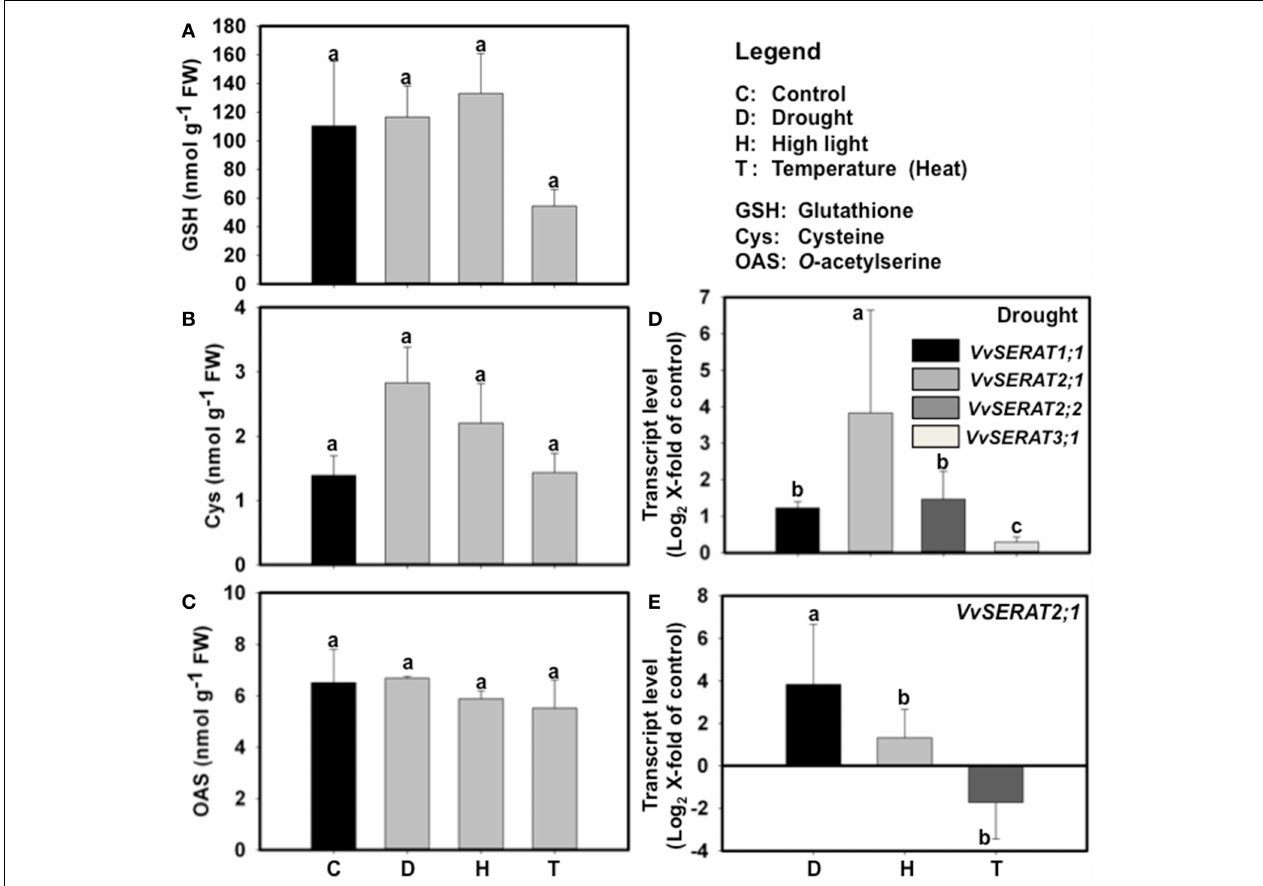
FIGURE 5 | Effect of abiotic stresses on the contents of thiols (GSH, A and cysteine, B) and OAS (C), and VvSERAT transcripts level in leaves of V. vinifera cv Touriga Nacional (E, D). D—Drought, H—High light, T—Heat Stress. cDNA obtained from leaves RNA was normalized against the